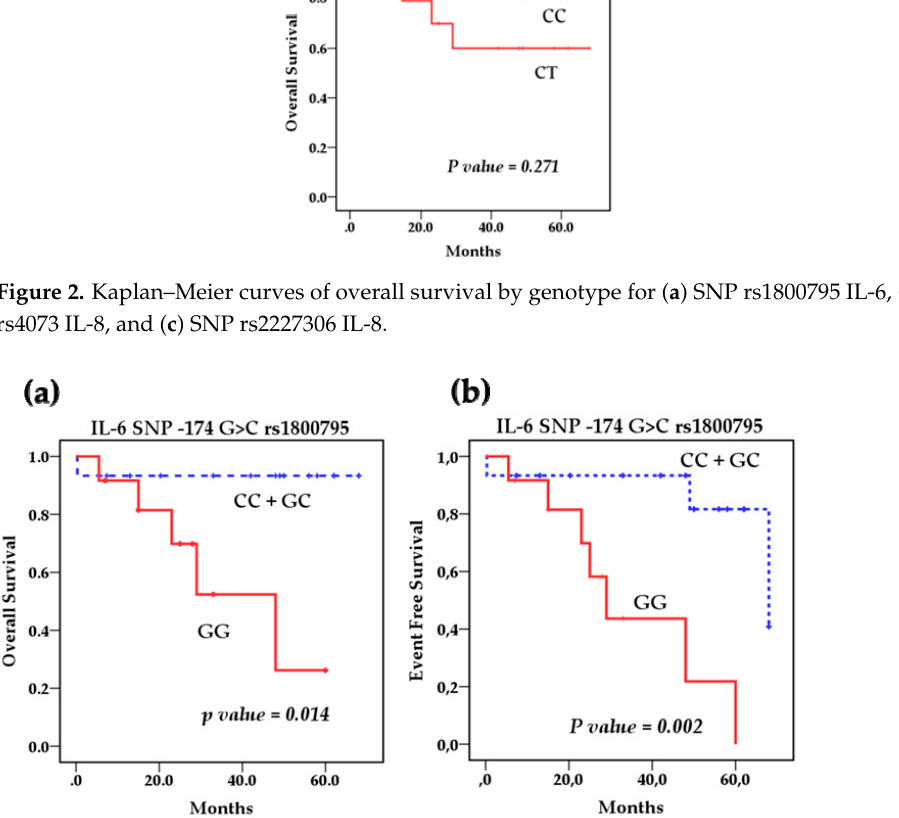
Figure 3. Kaplan–Meier curves comparing patients with a GG genotype against those with a CC and GC genotype of the IL-6 SNP rs1800795: ( a ) Overall survival (OS) and ( b ) event-free survival (EFS).